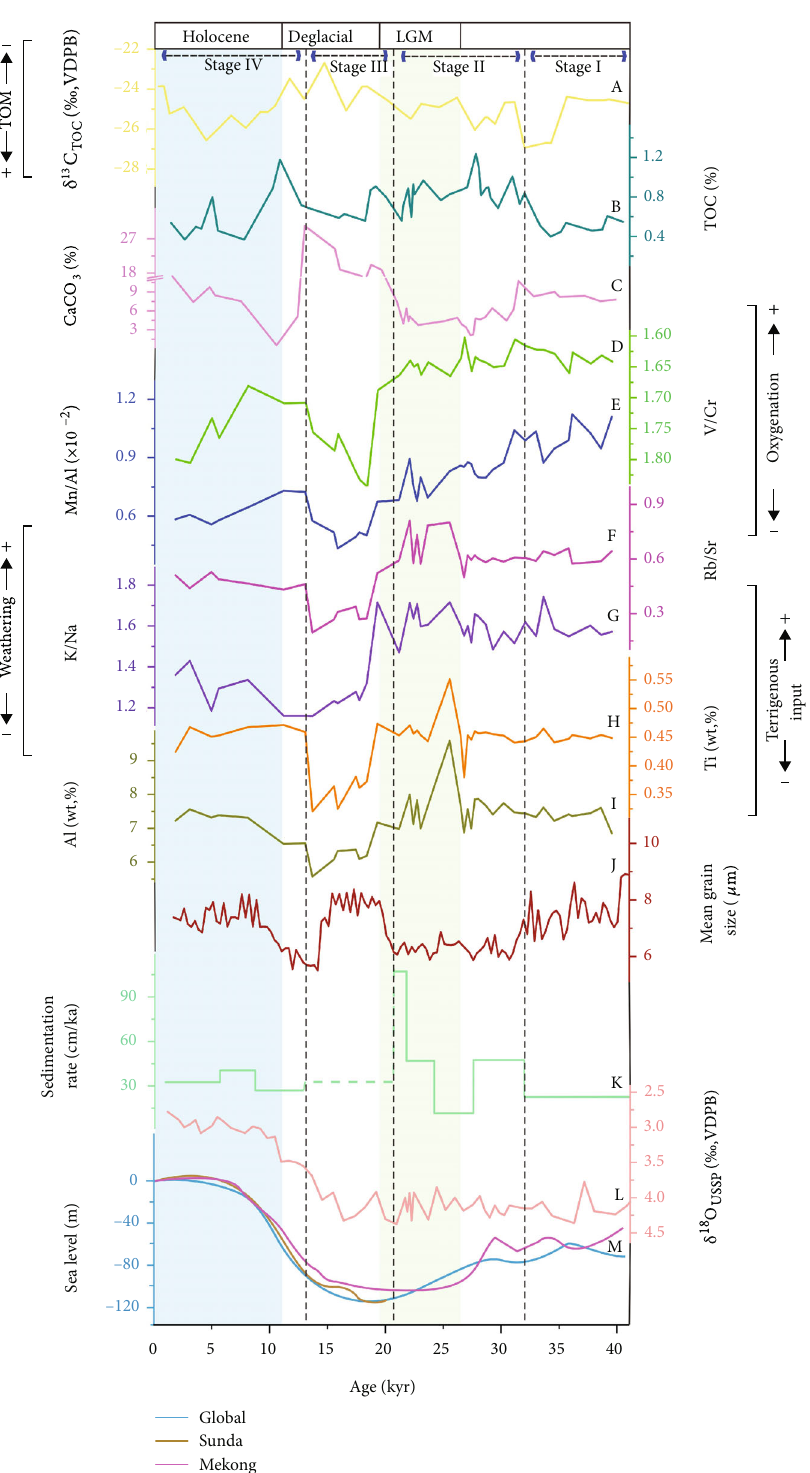
Figure 7: Temporal variations of paleorecords at core 973-4 sediments over the past 42 kyr. (a). Carbon isotope of total organic carbon [53]. (b) The TOC content [53]. (c) The CaCO content [31]. (d) – (i) Elements and elemental ratios (this study). (j) mean grain size [31]. (k) 3 sedimentation rate (summarized by [19, 29, 31, 83]), and the dotted line during stage III represents the average sedimentation rate. (l) Oxygen isotope of Uvigerina spp. [31]. (m) Sea-level curves for global change, represented by the blue line [84], Mekong River Estuary, represented by the pink line [85], and Sunda Shelf represented by the orange line [86]. Last Glacial Maximum (LGM) and Holocene are marked in green and blue shades, respectively [87, 88]. The dashed lines are the boundary between each evolutionary stage. LGM: Last Glacial Maximum. “ + ” and “–” in two sides represent increase and decrease,